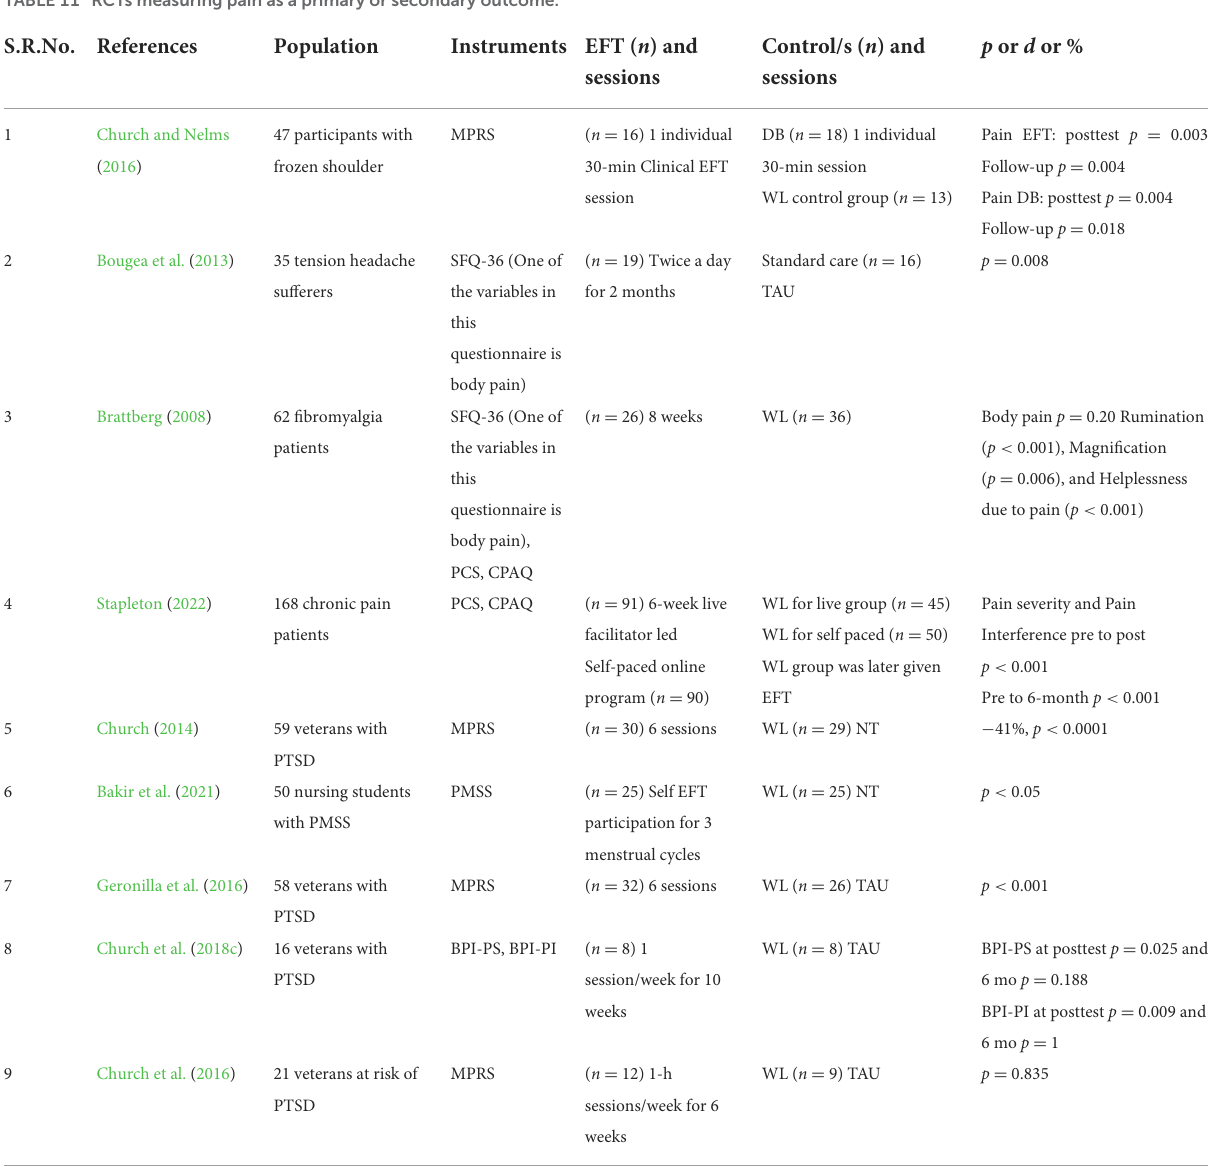
TABLE 11 RCTs measuring pain as a primary or secondary